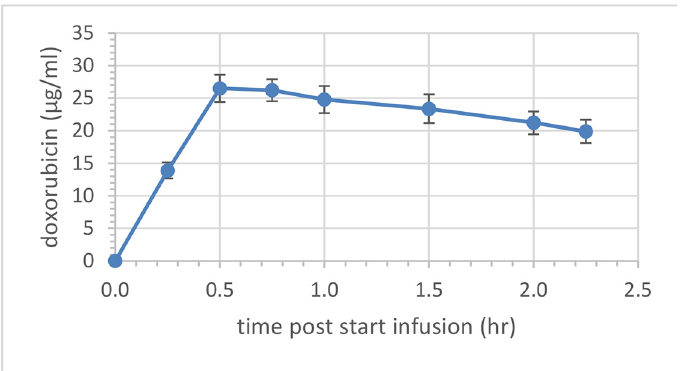
Fig 1. Mean ( ± SEM) plasma concentration of total doxorubicin in pigs in Study A. Pigs (n = 3) received a single, intravenous infusion of LTLD (1.43 mg/kg) over 30 minutes.